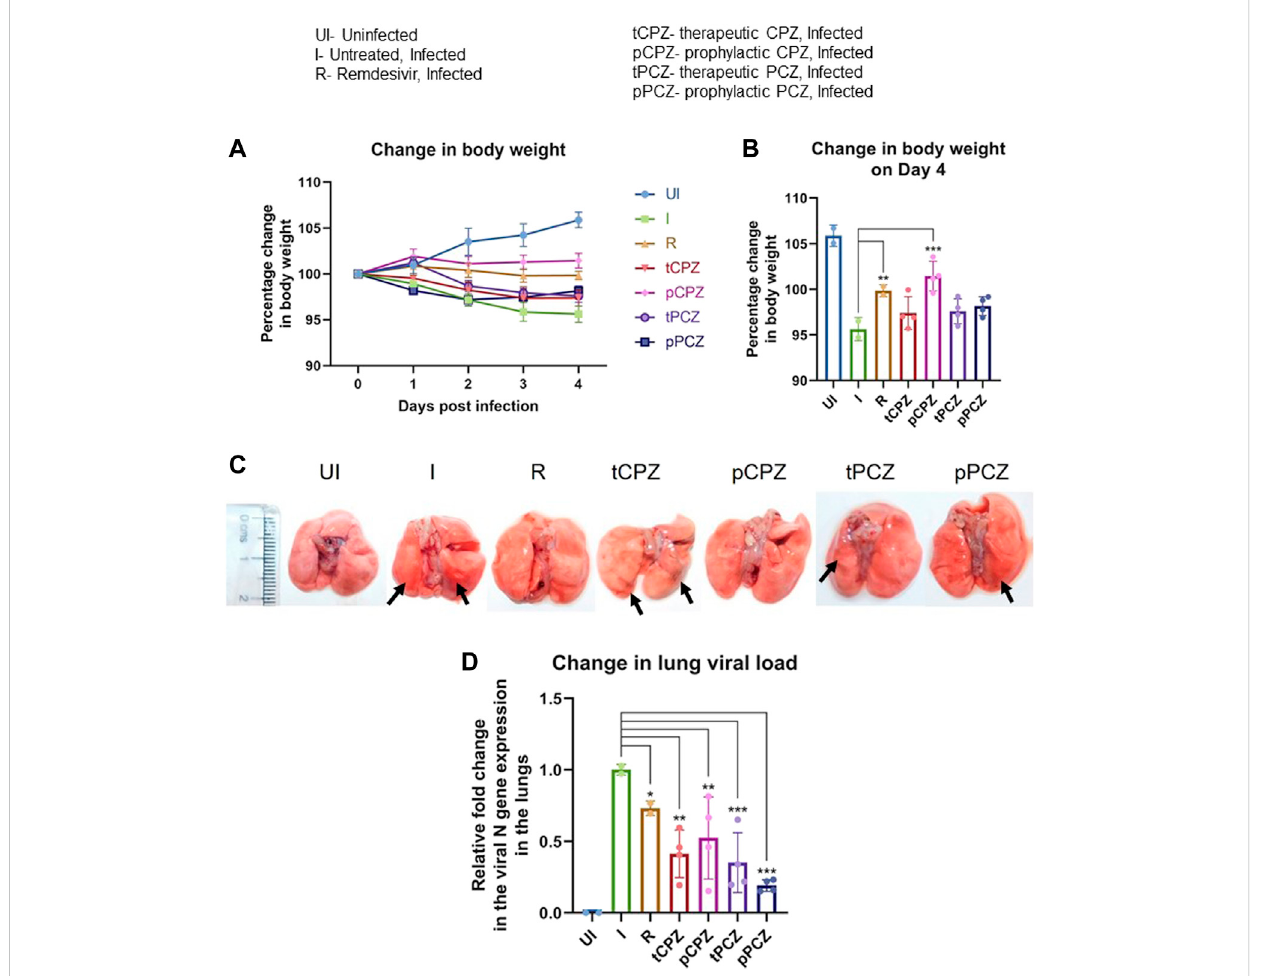
therapeutictreatmentofCPZ(tCPZ)andPCZ(tPCZ). (B) Percentage%changeinbodyweightofhamstersofdifferenttreatmentgroupsonthefourthday post infection. Mean ± SE (n = 3); ordinary one-way ANOVA. (C) Images of the excised lungs from hamsters of different treatment groups, showing gross morphology with pneumonitis region. (D) Relative fold change in theN gene expressionof SARS-CoV-2 representing viral load in thelung